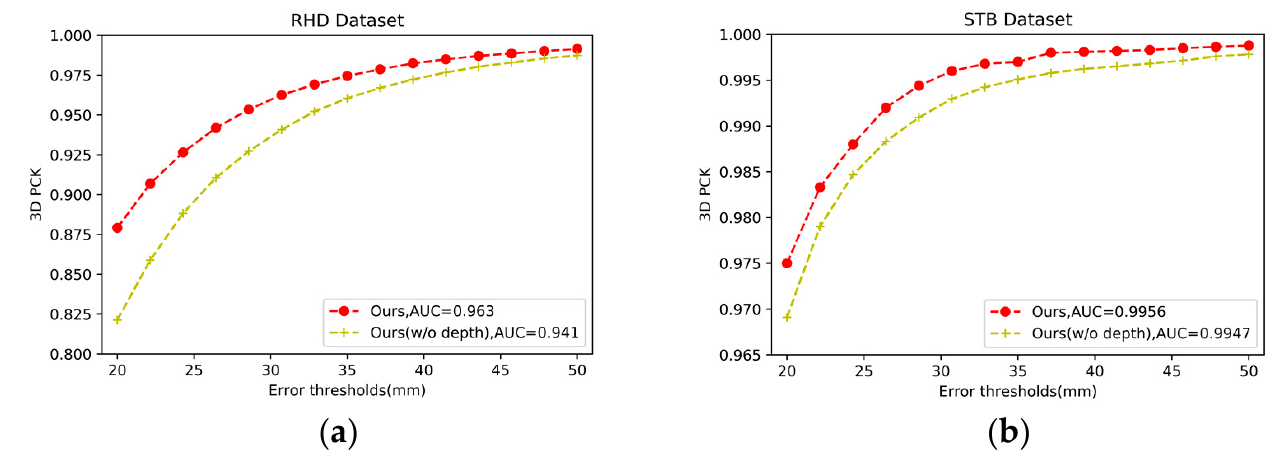
Figure 4. Ablation study for the training data on the RHD ( left ) and STB ( right ). ( a ) Describes the effectiveness of RGB image and depth map input in the RHD. ( b ) Describes the effectiveness of RGB image and depth map input in the STB.